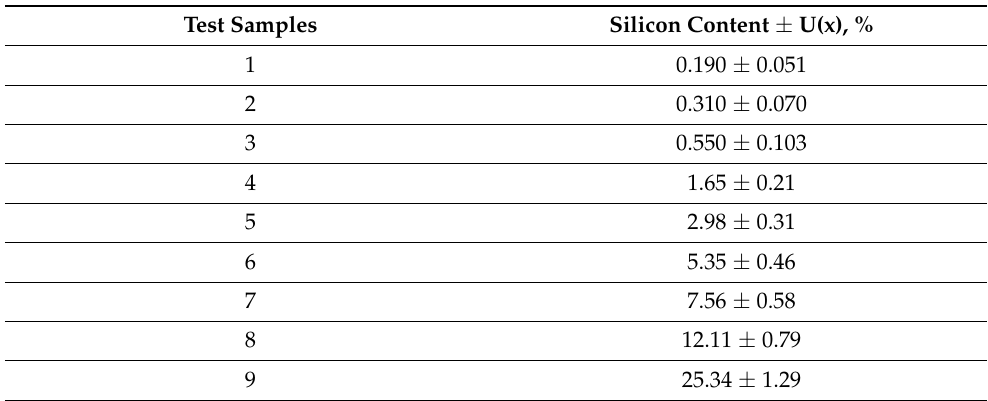
Table 5. Silicon content in test